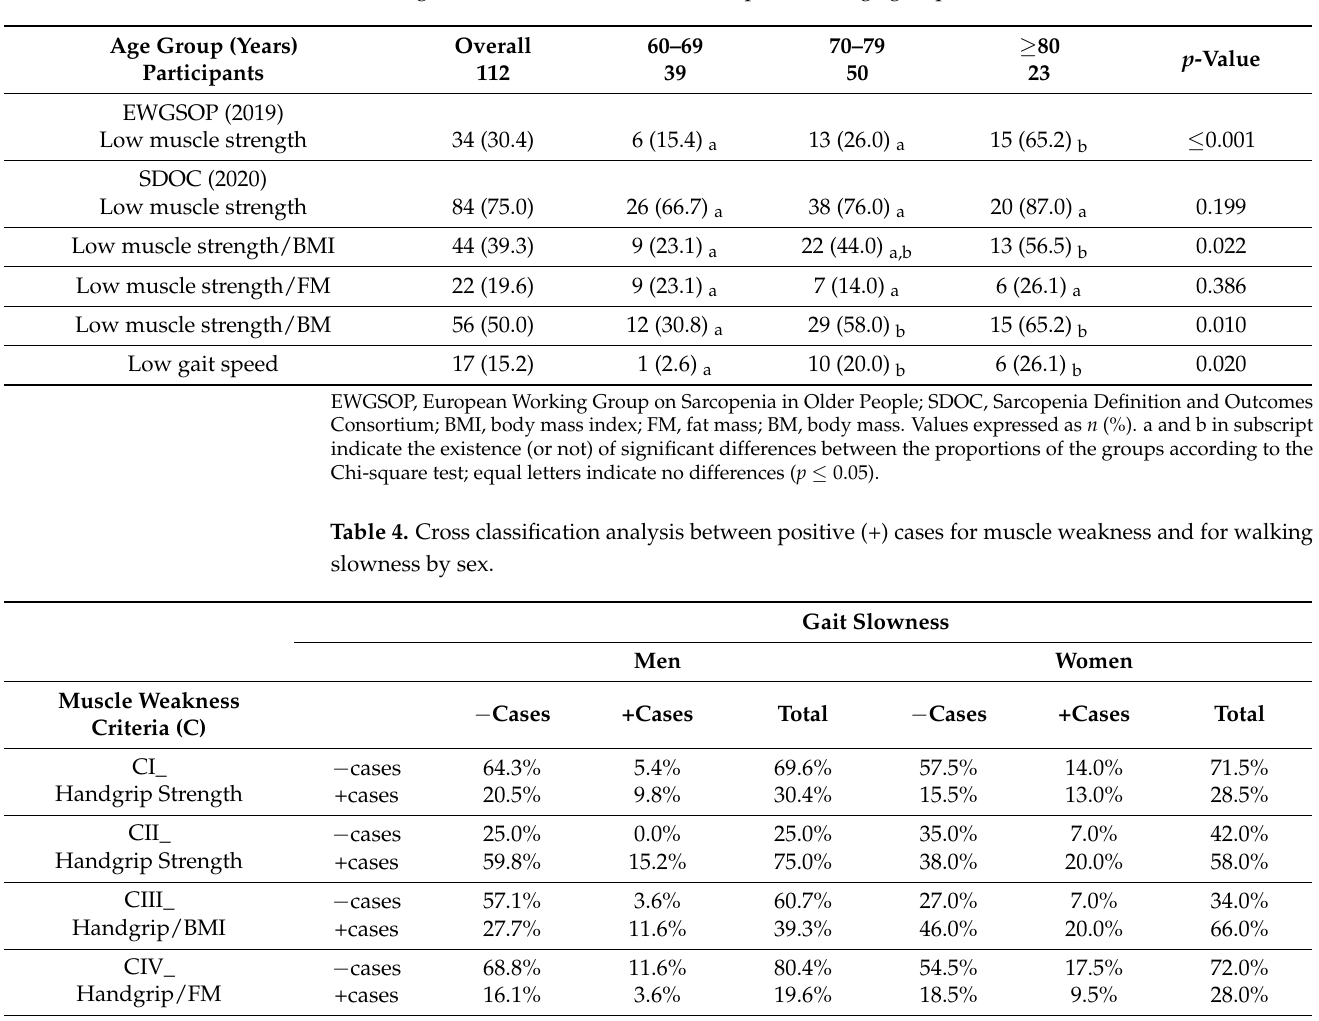
Table 3. Prevalence (%) of low muscle strength and low gait speed in elderly of Northern Brazil according to consensus definition of sarcopenia and age group—MEN.